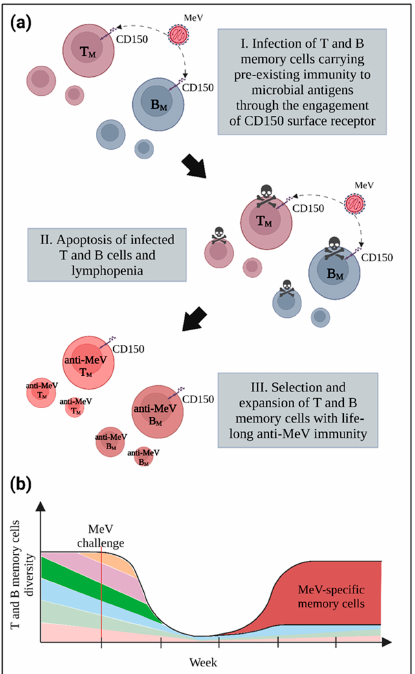
Figure 6. The immune paradox. ( a ) Infection and induction of apoptosis in memory T and B lymphocytes following MeV infection provokes lymphopenia due to the loss of pre-existing immune cells. ( b ) The dramatic shrinkage in memory cell pool diversity towards previously encountered pathogens, represented here by different colors, is associated with the development of a lifelong anti-MeV immunity mediated by the selection and expansion of T and B memory cells with specificity for MeV, represented in